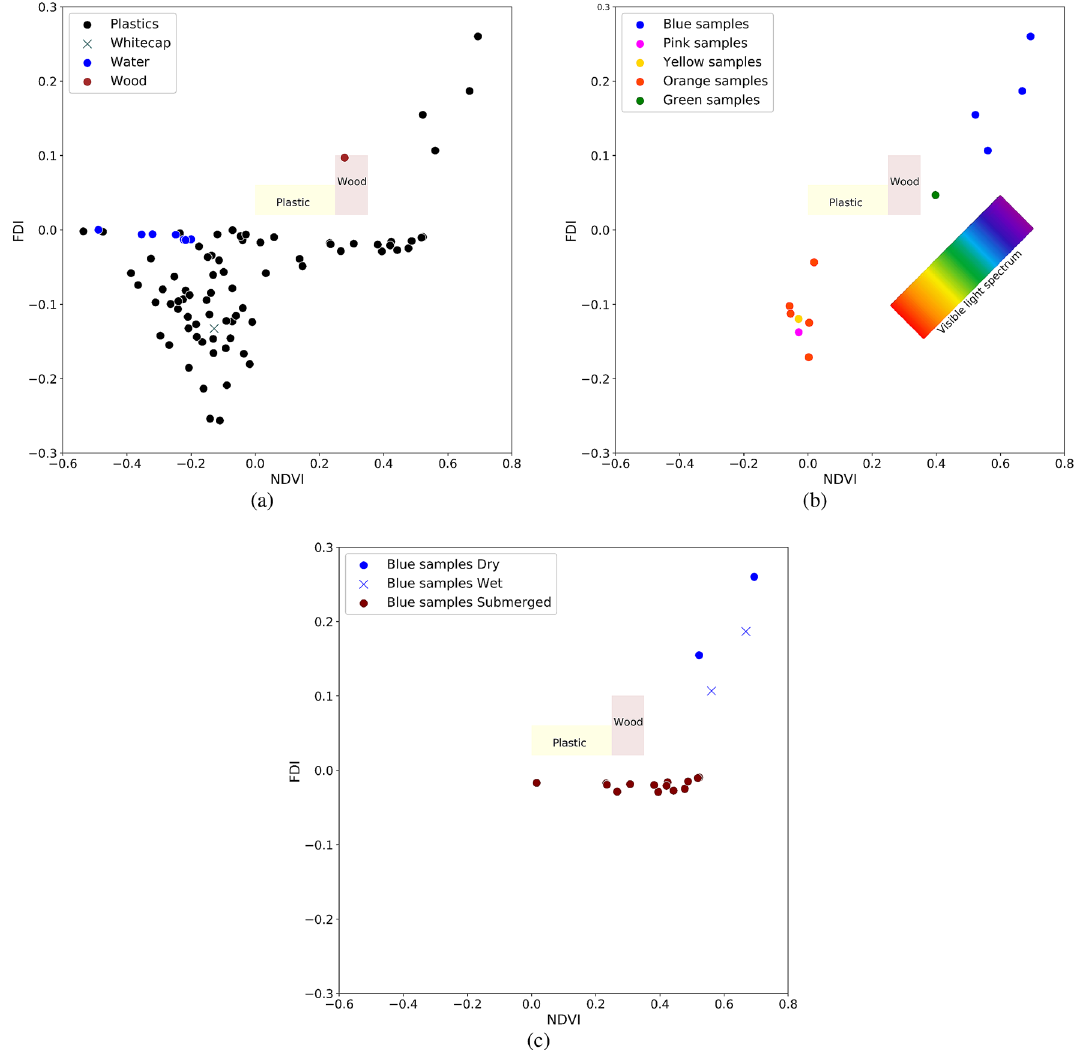
Figure 6. FDI and NDVI for ( a ) plastic samples, wood, whitecap and water, ( b ) different colors and ( c ) effect of submersion. Yellow and brown rectangular correspond to Biermann’s proposed range for plastic and wood respectively. Water and all submerged data are collected in zero, 75 and 321 mg/l sediment condition.